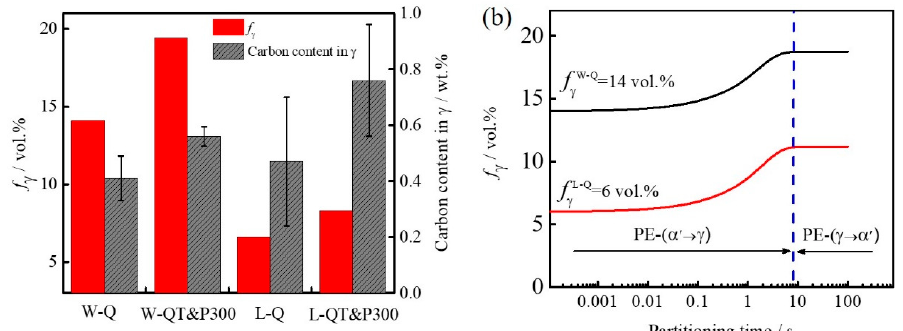
Figure 3. ( a ) The volume fraction of retained austenite ( f γ ) and carbon content in γ at different stages of W-QT&P300 and L-QT&P300 processes. ( b ) The evolution of the austenite fraction during tempering at 300 °C with different initial austenite fractions predicted by QP-PE models.